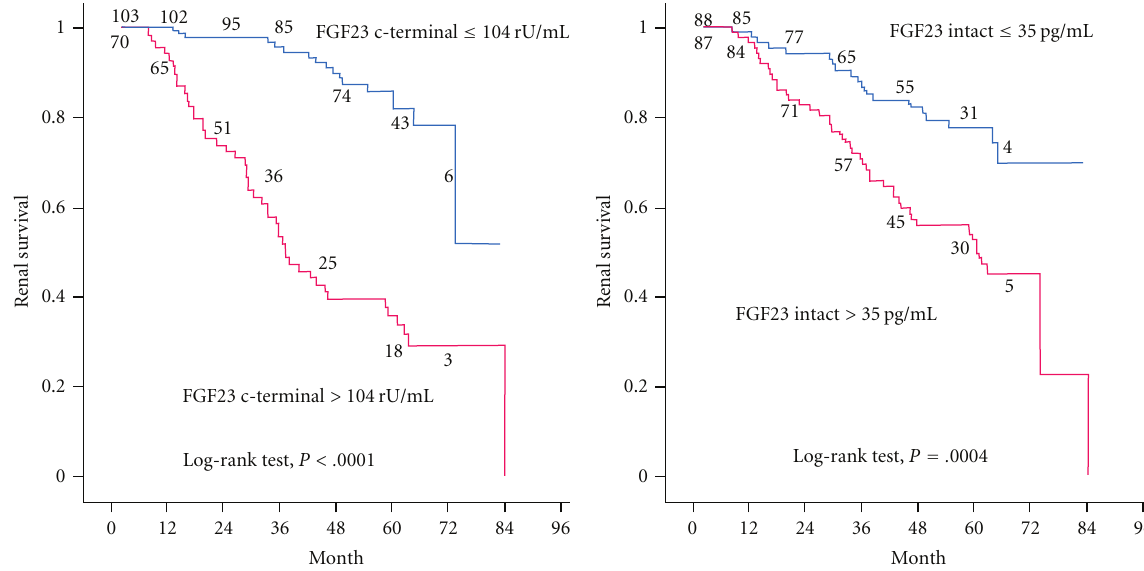
Figure 3: Association between serum FGF-23 levels and renal survival. Cited from the J Am Soc Nephrol 2007; 18: 2600–8 by Fliser et al.